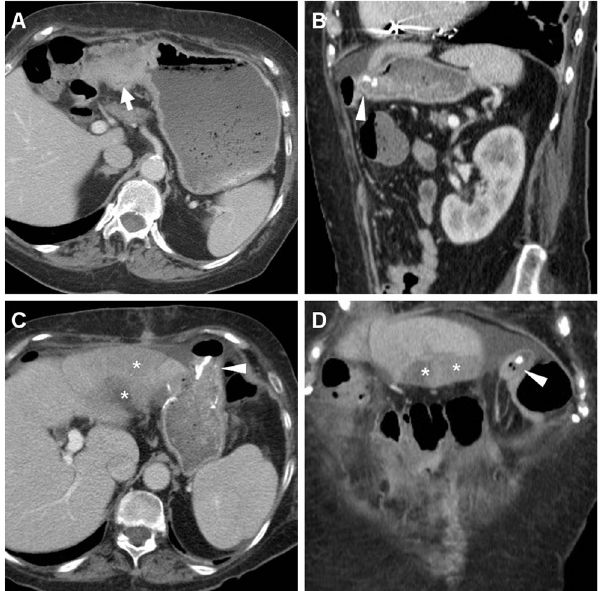
Fig. 12 An 81-year-old male with advanced, obstructing antral cancer (thick arrow) as preoperatively depicted by CT (A) underwent palliative partial gastrectomy with Roux-en-Y reconstruction. During prolonged hospitalization the patient experience anemization and failure to thrive. Early CF (not shown) showed slow transit through EJS. On 11th POD, contrast-enhanced CT (B-D) showed some ingested materials in the remnant stomach (+), stapled EJS (arrowheads), some residual intraperitoneal air and fluid, inhomogeneous hypoattenuation of the 3rd